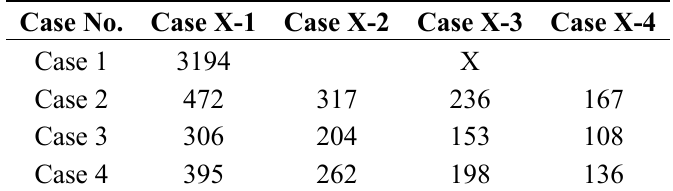
Table 1. Quantity (number) of rain barrel of each designed regular